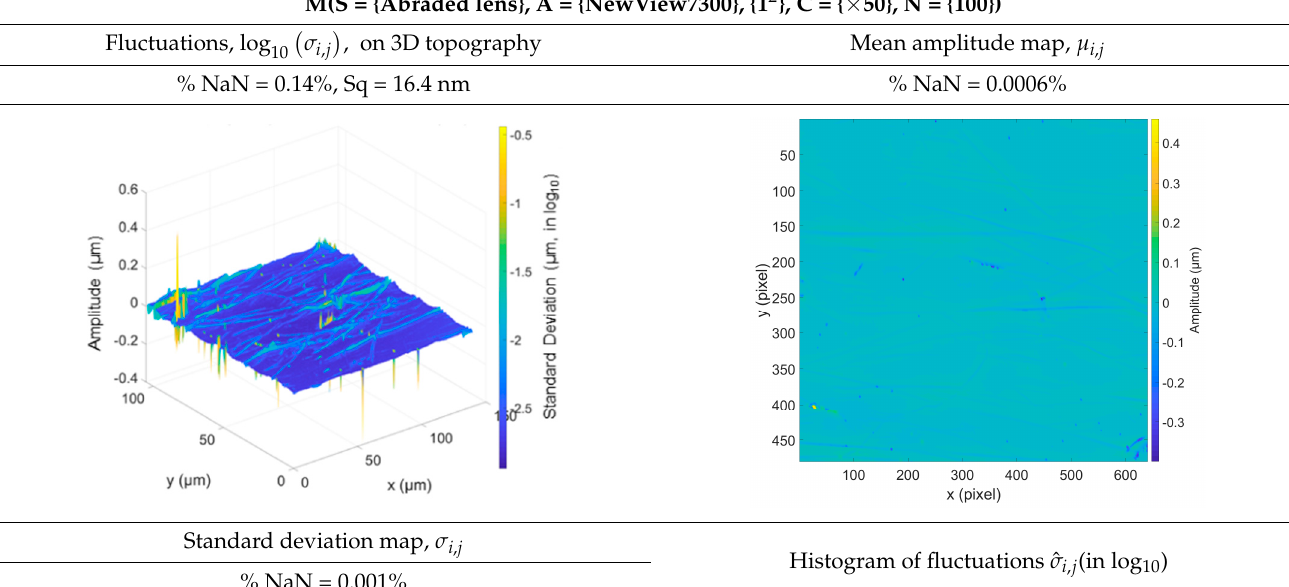
Table A3. Abraded Ophthalmic Lens (Essilor), Location n ◦ 1.